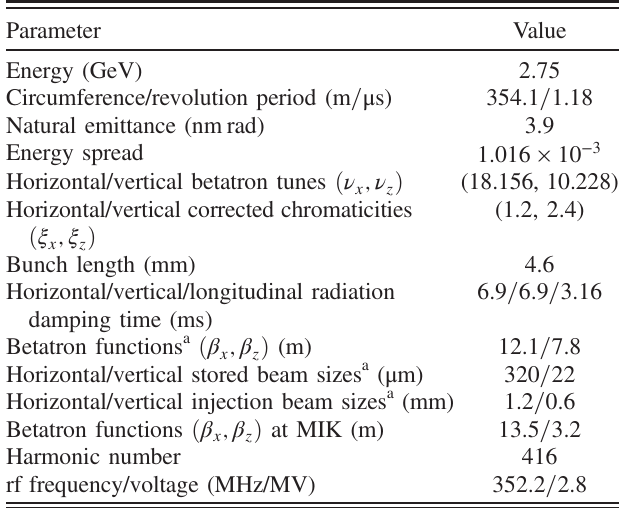
TABLE II. Main parameters of the SOLEIL storage ring.